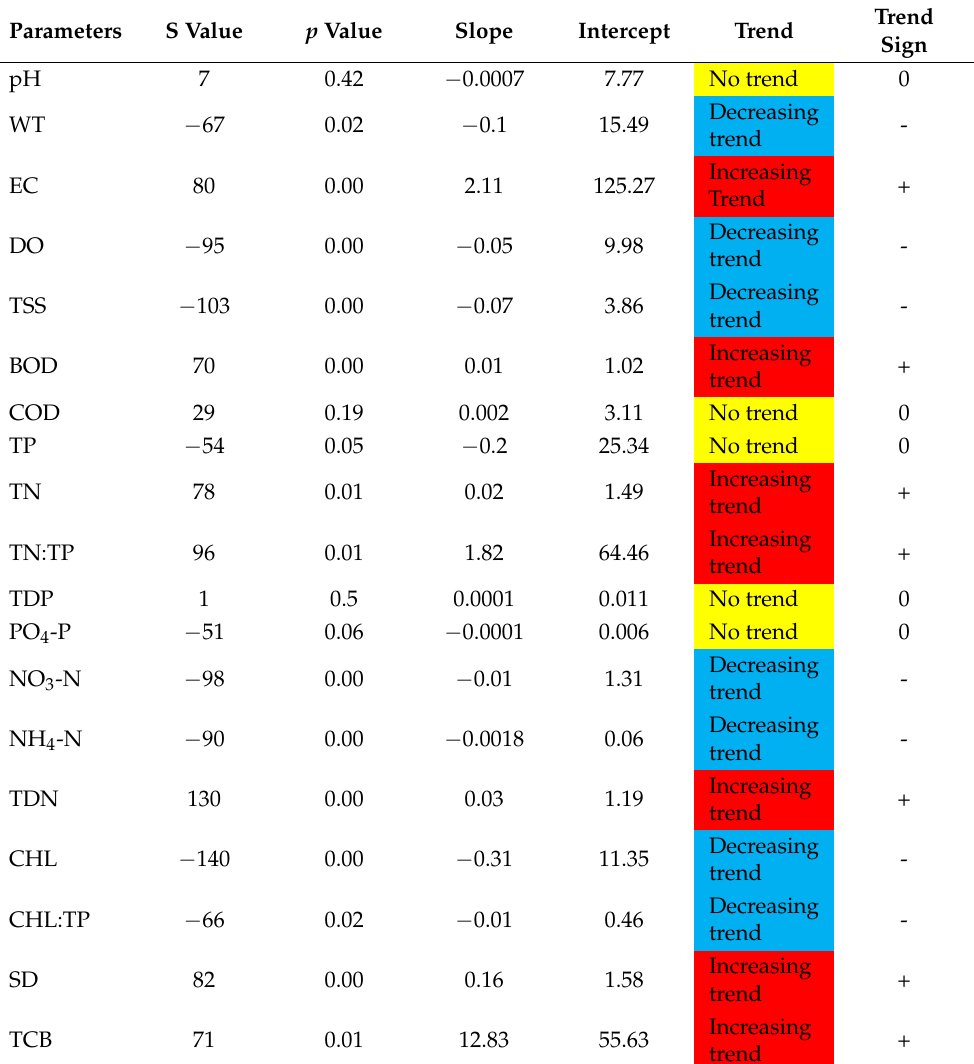
Table 2. Long-term trend analysis of water quality parameters based on Mann–Kendall trend (MKT) test in Daecheong Reservoir during